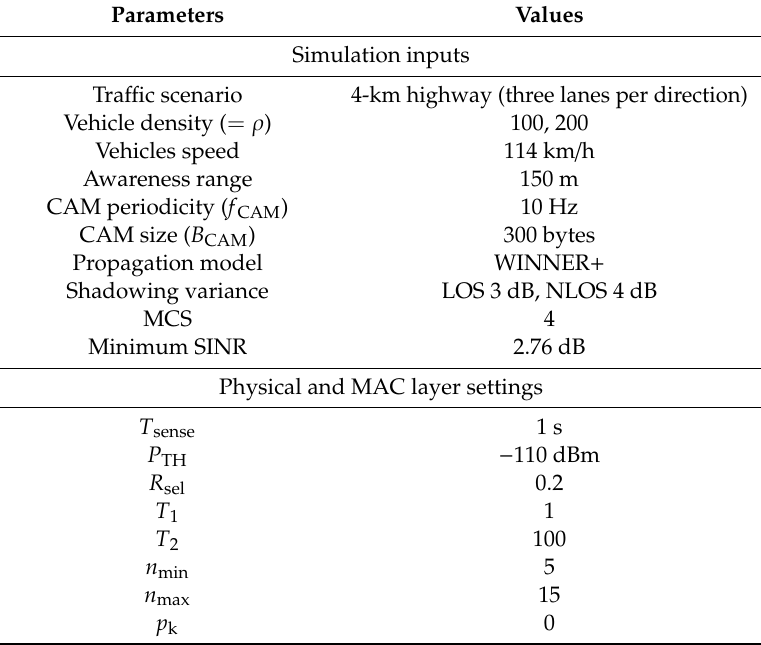
Table 2. Summary of parameters and settings for Simulation 1